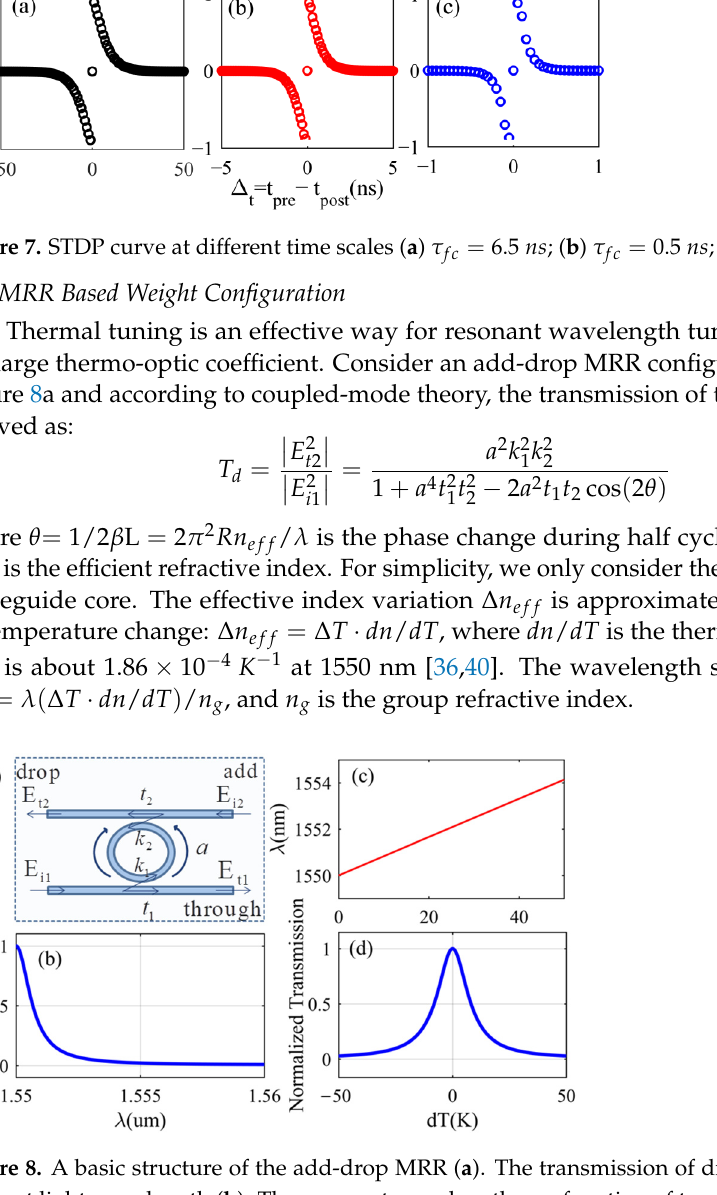
Figure 6. ( a – d ): The resonance frequency detuning caused by the Kerr effect, FCD and thermo ‐ optic effect as a function of time.